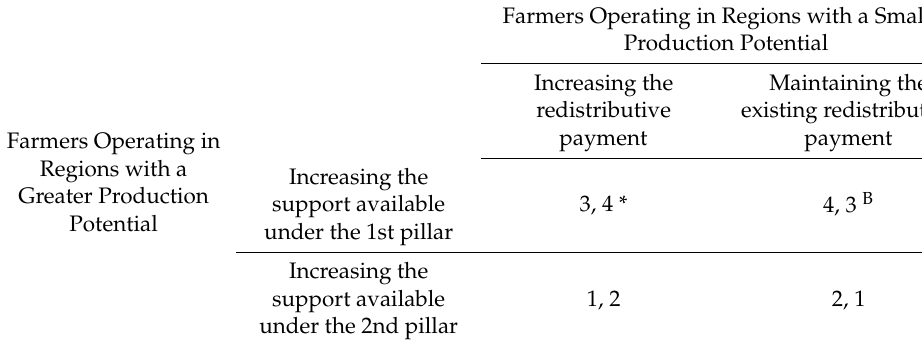
Table 3. Pay-off matrix for the non-cooperative